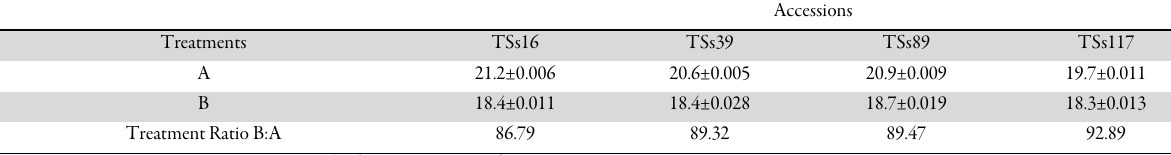
Table 1. Fruit set percentage by treatments A and